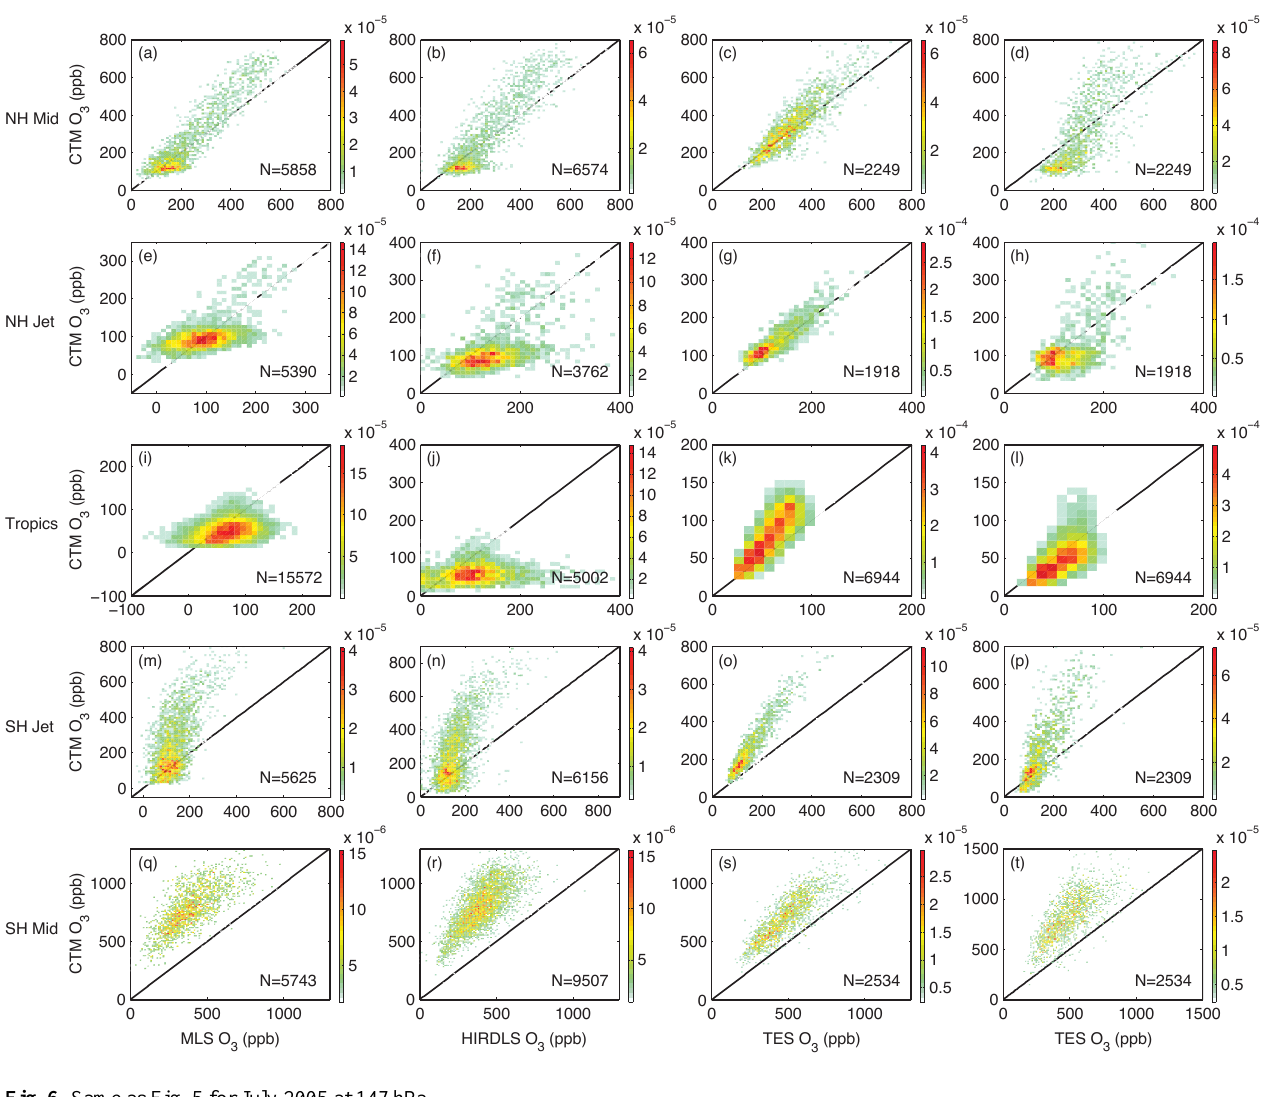
MLS HIRDLS TES TES* Regions 215hPa 147hPa 215hPa 147hPa 215hPa 147hPa 147hPa NH Mid-L 10.0 ± 79.2